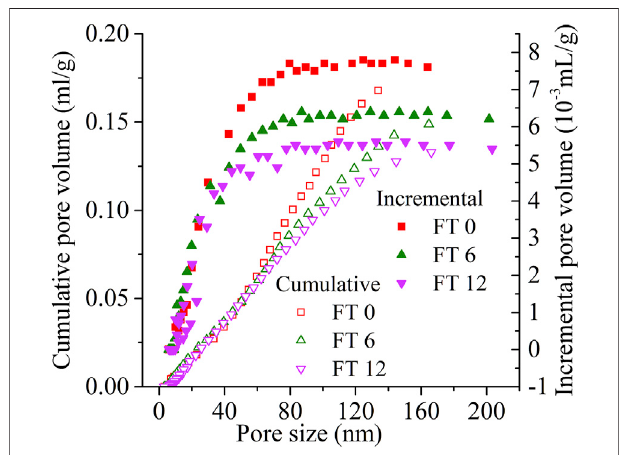
FIGURE 10 | Pore size distributions of S/S sediments in FTs by NAP.